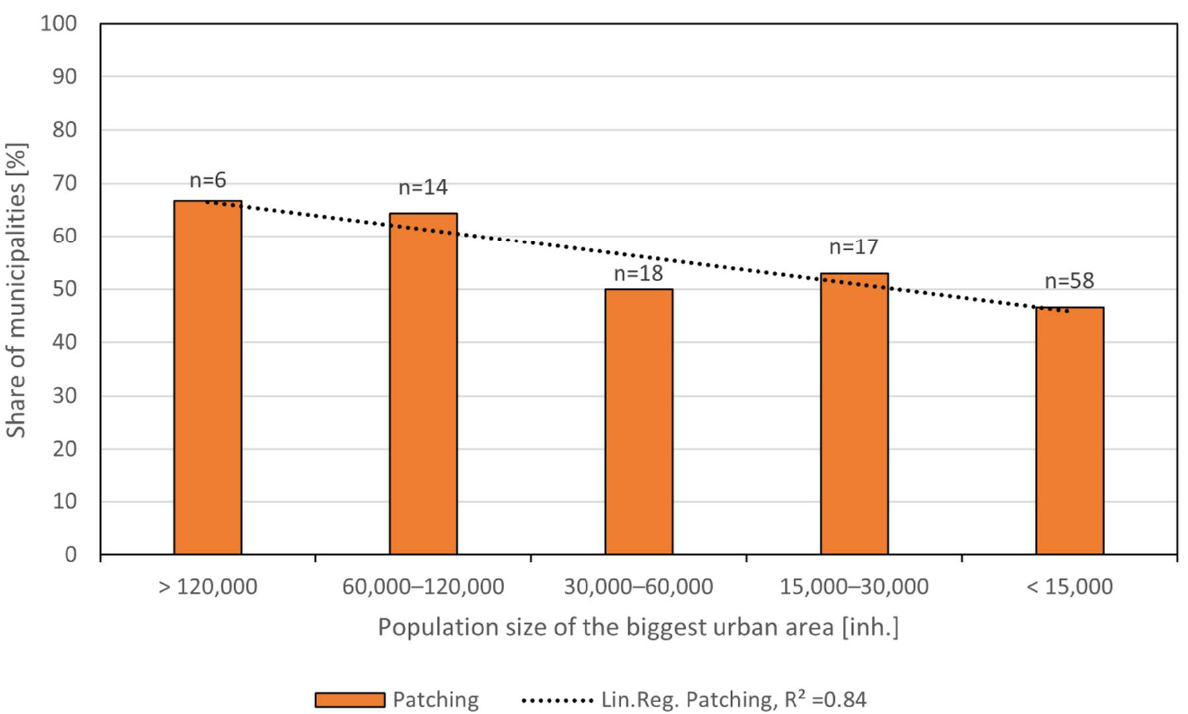
Figure 9. Correlation of problematic frequency of patching and population size of the biggest urban area for each municipality.